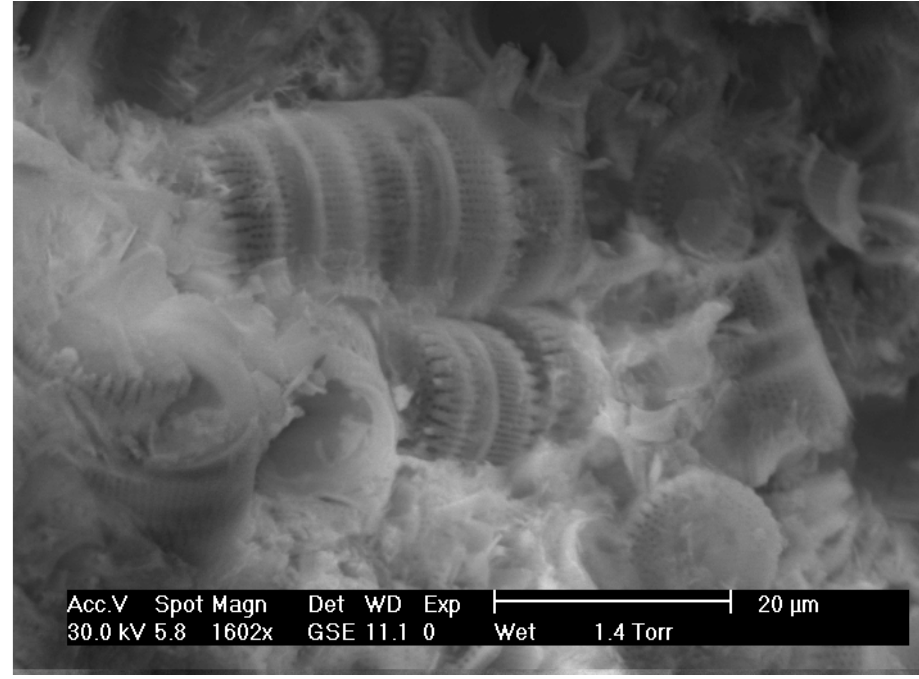
Figure 3. Colonies of well-preserved cylindrical diatom frustules hosted in a clayey matrix.